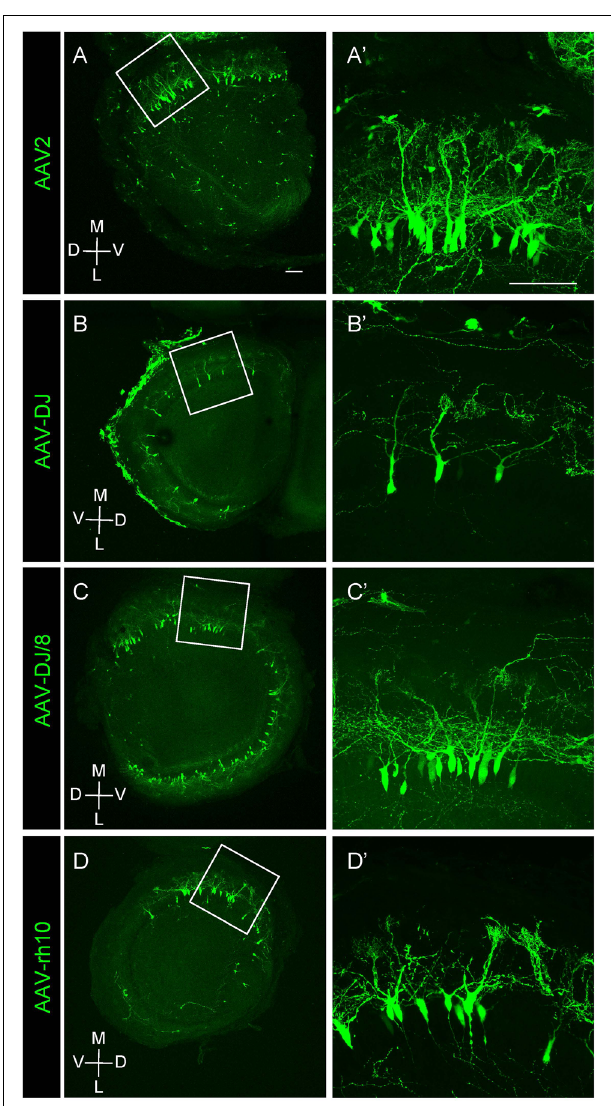
FIGURE 2 | Expression of different AAV serotypes in mouse mitral cells. (A–D) Gene transduction to mitral cells by AAV2, AAV-DJ, AAV-DJ/8, and AAV-rh10. The coronal sections of the OB from P1 pups transduced by each AAV serotype showed no obvious difference for the neuronal tropism. The dorsal-ventral axis and the medial-lateral axis are indicated. Panels (A (cid:48) –D (cid:48) ) are magnified images of the corresponding boxed area in the left panels (A–D) . Scale bar, 100 µ